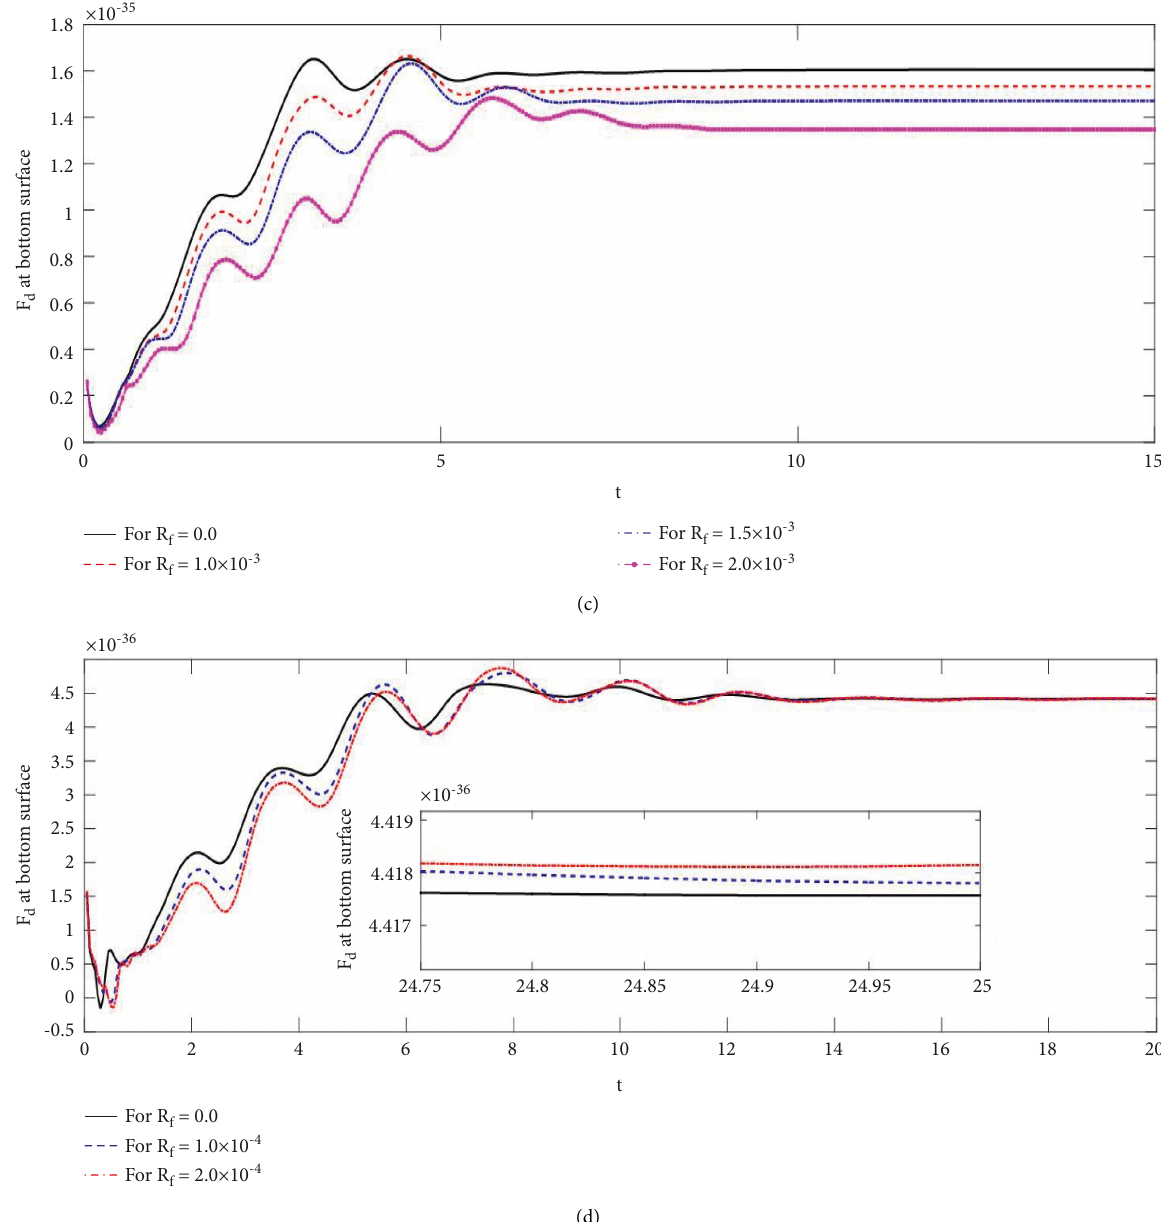
Figure 5: Drag force at the bottom surface with L � 0 . 25 and varying values of R (d) for Re �